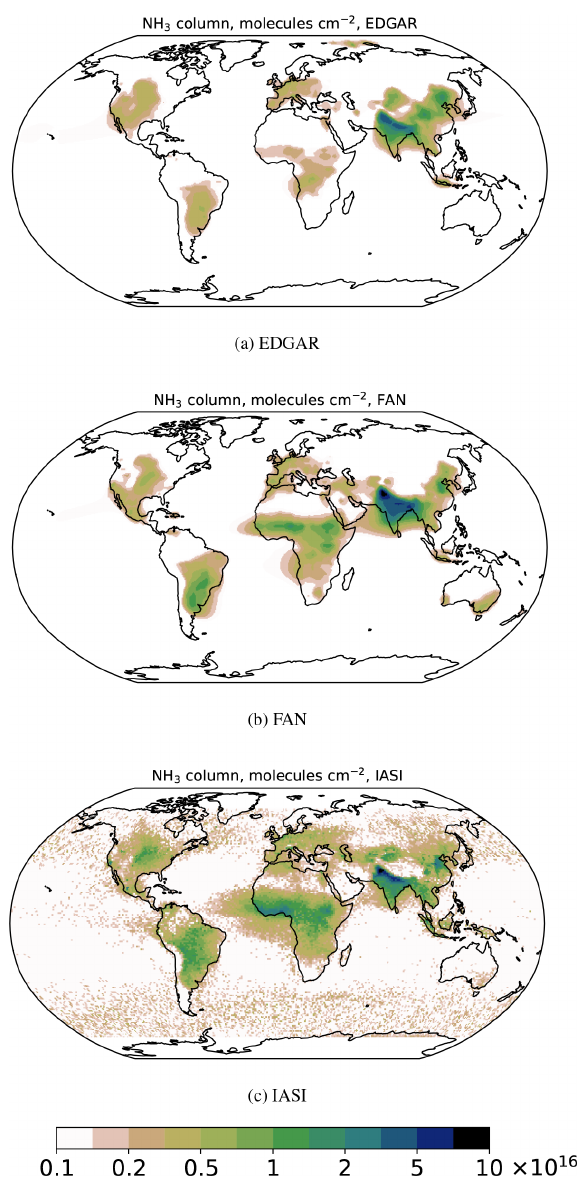
Figure 2. Column density of NH 3 (moleculescm − 2 ) in the (a) EDGAR and (b) FAN simulations for 2010–2015 and (c) in the IASI dataset (Van Damme et al., 2018b) averaged over 2008–2016. The results for CEDS and HTAP are shown in Fig.